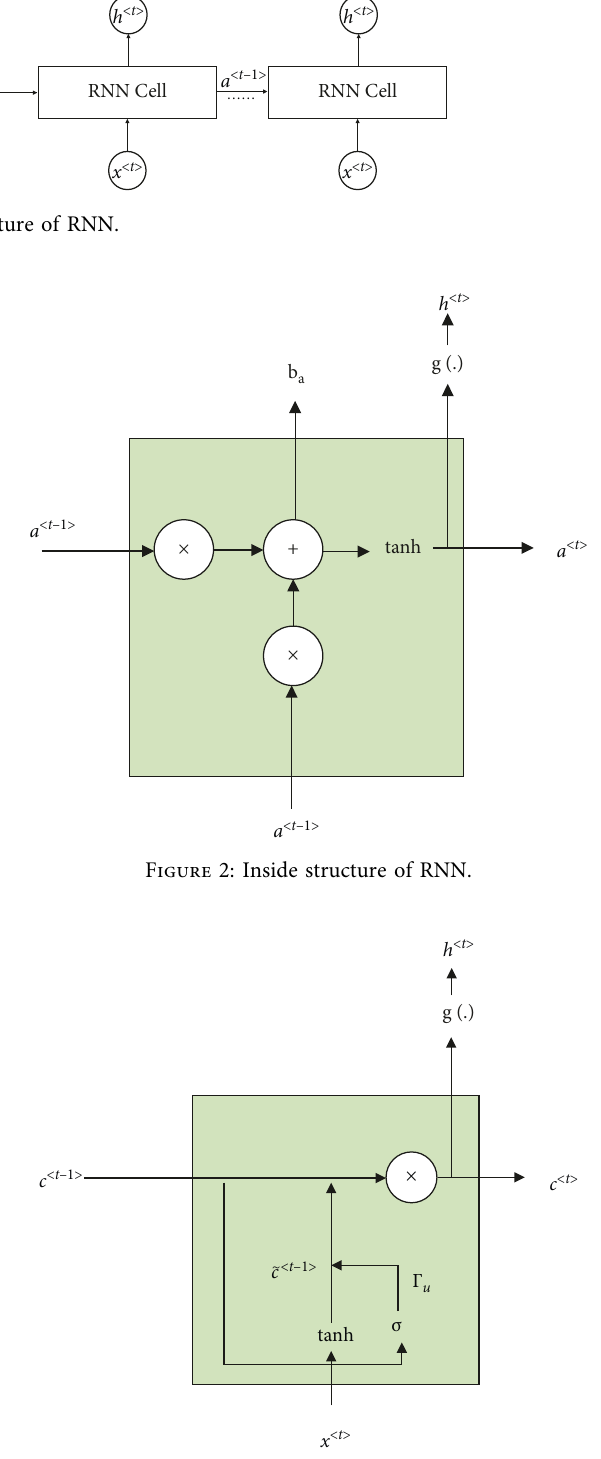
Figure 3: Inside structure of simplified